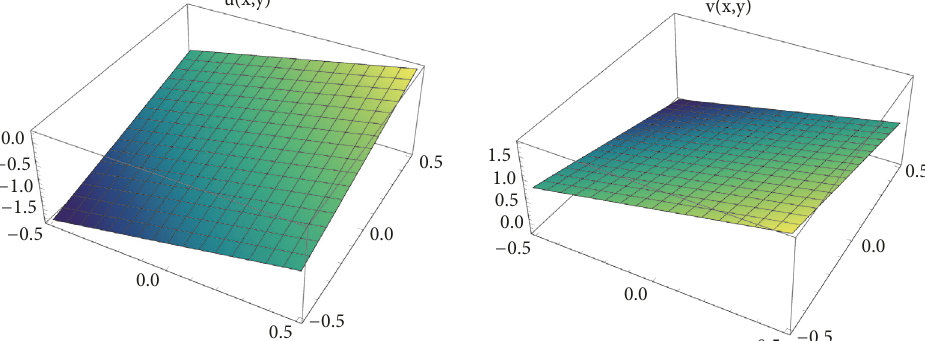
Figure 4: The exact solution of Example 9 for 𝛼 = 0.99 and t =